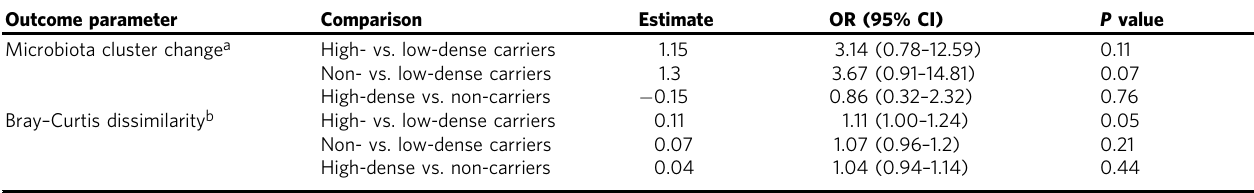
Table 3 Dynamics of microbiota composition associated with pneumococcal exposure Outcome